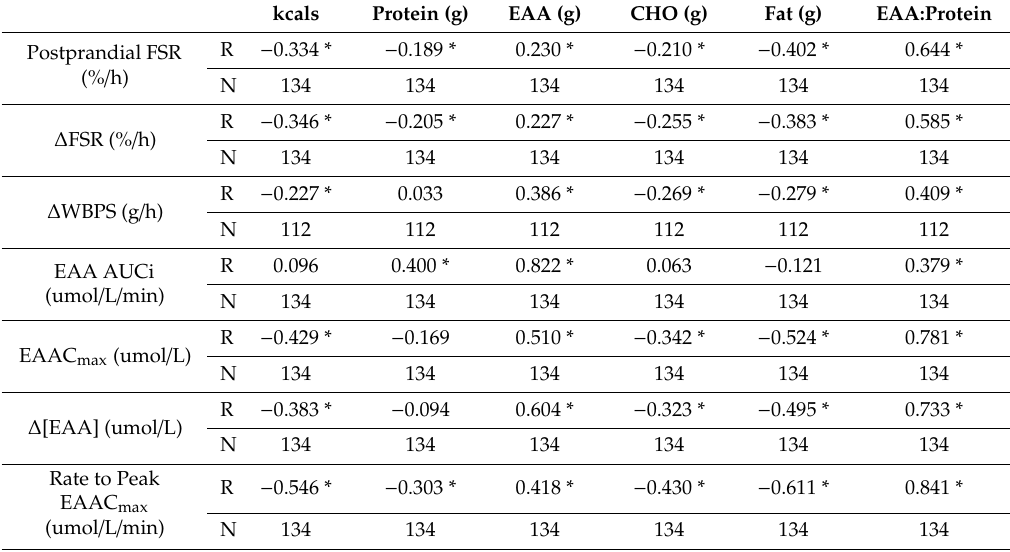
Table 3. Correlations between macronutrients and physiological variables 1 .